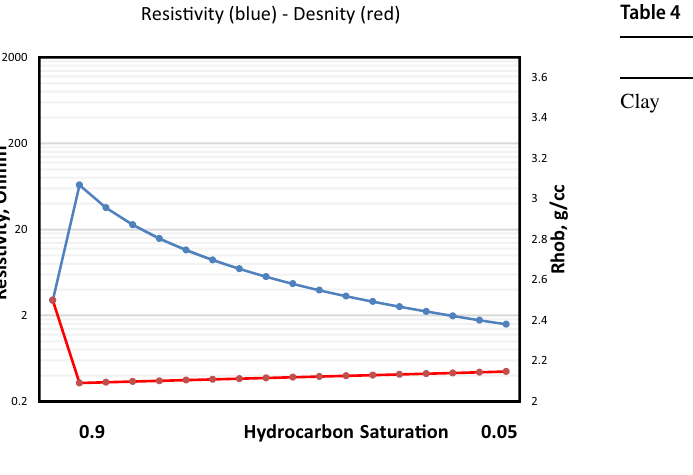
Fig. 6 Density–resistivity overlay, V